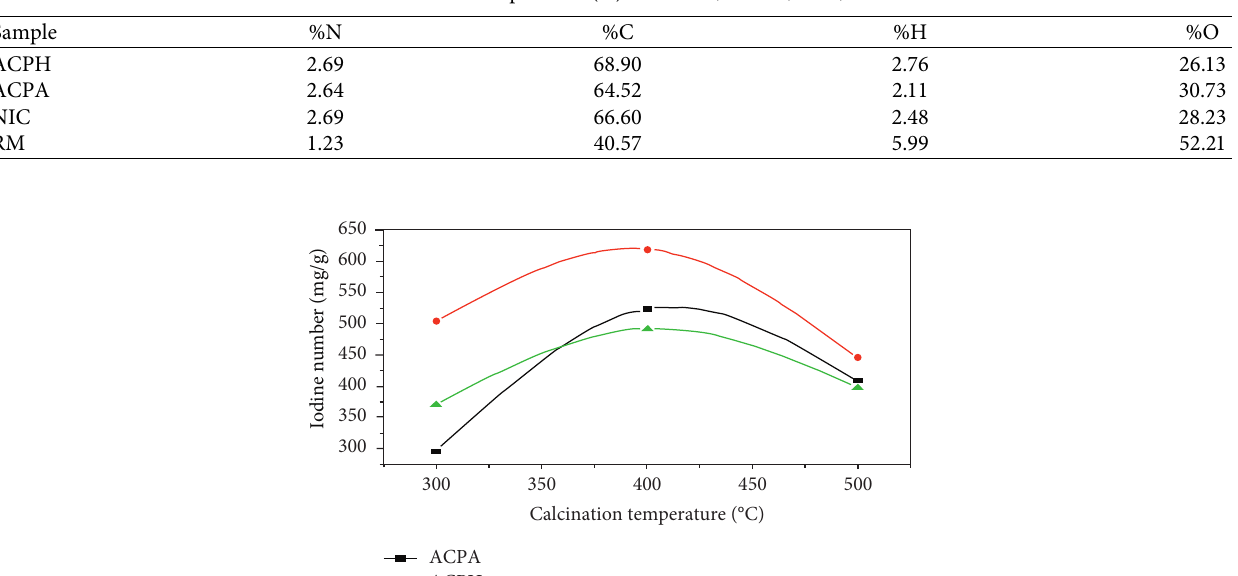
Figure 2: The proximate analysis giving the composition of the peelings of cassava tubers. Table 2: Elemental composition (%) of ACPH, ACPA, NIC, and RM.